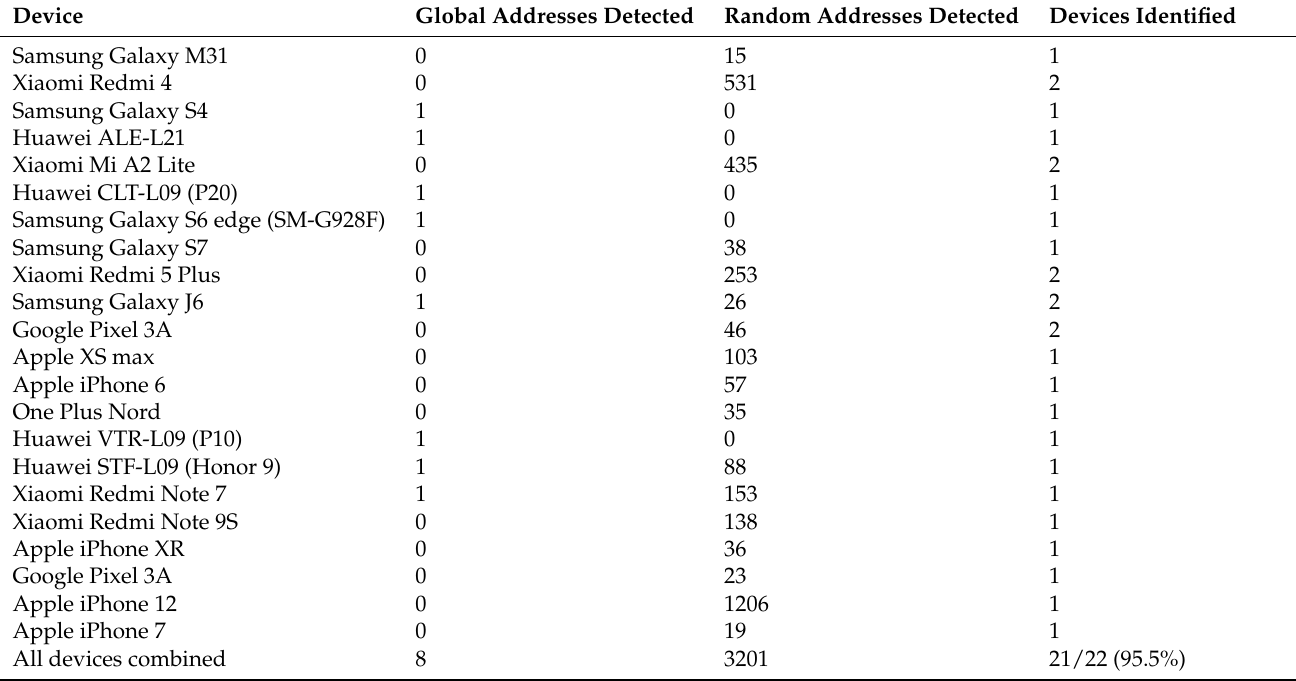
Table 3. MAC de-randomization results for individual devices from the labeled